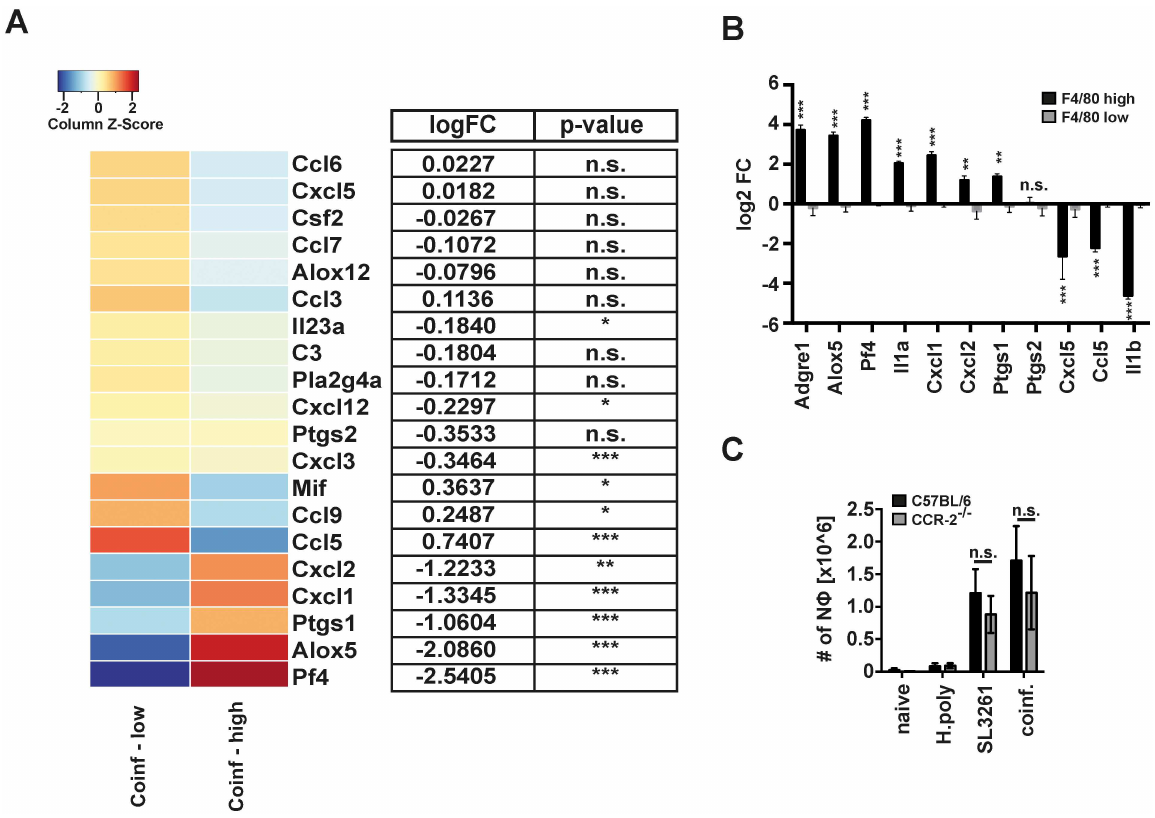
Fig 6. F4/80 high M Φ preferentially produce neutrophil recruiting factors. (A) Heatmapof relative expressionof neutrophil chemotactic factors and enzymes involvedin the generationof neutrophil chemotactic factors in F4/80 high and F4/80 low M Φ from co- infected animals. (B) qRT-PCR of selectedchemotacticfactors identifiedin A. One representativeexperimentof 2 with 6 animalsper group shown(C) Number of peritonealneutrophilsin uninfected(na ï ve)individually(SL3261and H.poly) or co-infected(coinf.) WT (black bars) or Ccr2 -/- (grey bars) mice. One representative experiment of 2 shown. ** : p < 0.01, *** : p < 0.001;n.s.: not significant.